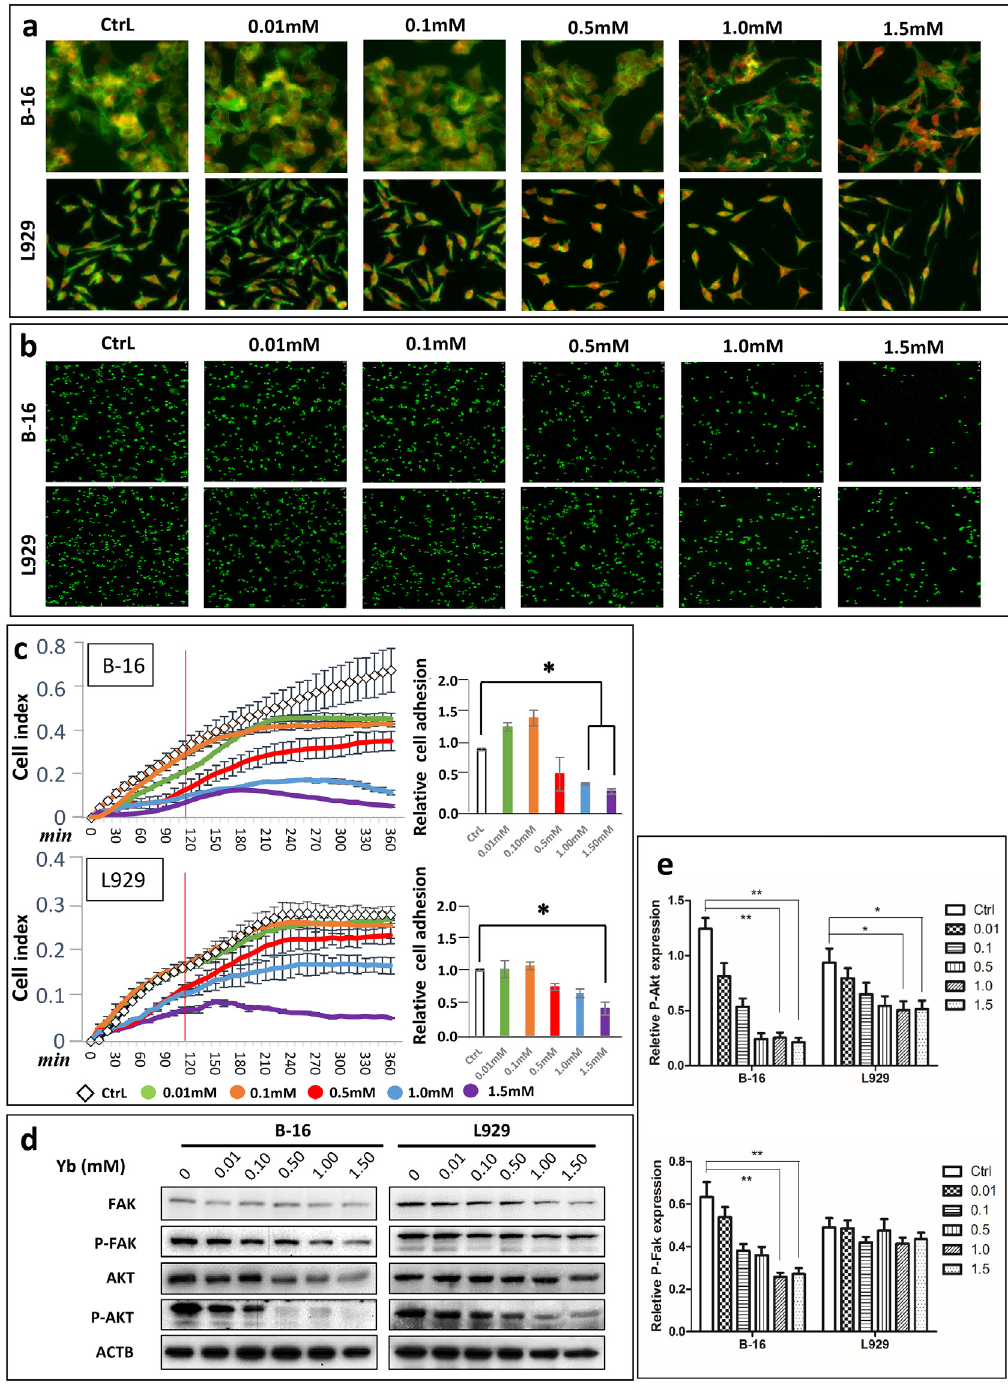
Figure 7: Yb 3+ induced the anoikis of B-16 cells by FAK signaling. (a) FITC-phalloidin staining for F-actin in B-16 and L929 cells on hydrogels containing different concentrations of Yb 3+ . (b) Cell adhesion assays of B-16 and L929 cells on the same hydrogels using SYBR I. (c) RTCA assays for detecting cell adhesion and spreading of B-16 and L929 cells cultured in medium containing different concentrations of Yb 3+ within 6 h. The relative cell adhesion rates are shown for the 2 h timepoint (*p < 0.05). (d) Western blot of anoikis marker proteins (FAK, Akt and their phosphorylated forms) in B-16 and L929 cells treated with medium containing different concentrations of Yb 3+ at 24 h. (e) Relative expression of P-Akt and P-Fak in B-16 and L929 cells based on the results of western blot analysis (*p < 0.05, **p <